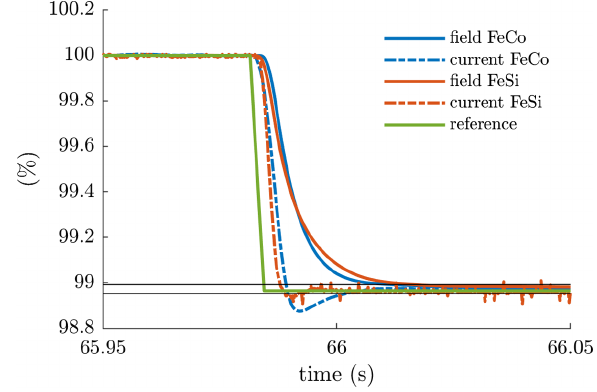
FIG. 23. Low current step